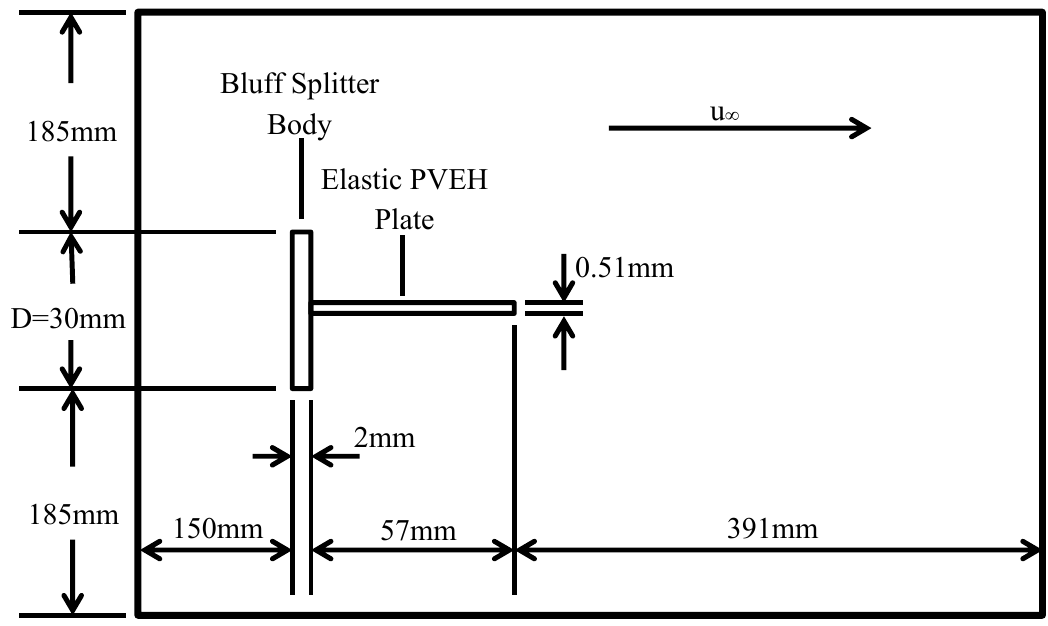
Figure 5. Simulation setup wind direction towards model ( D = 30 mm).